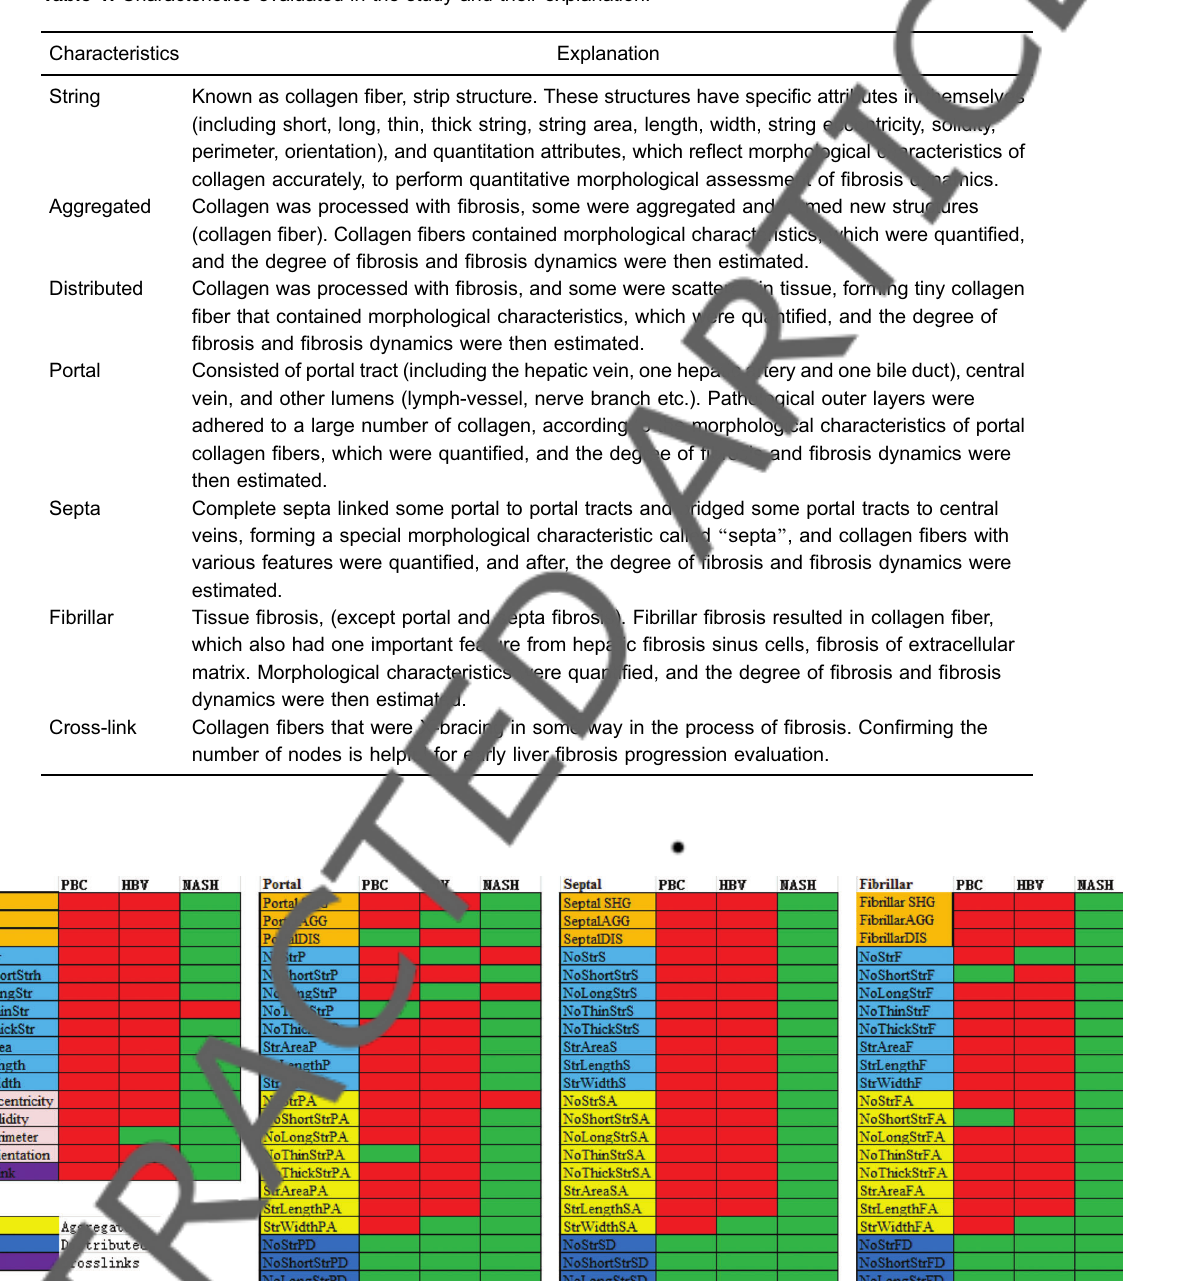
Table 1. Characteristics evaluated in the study and their explanation.